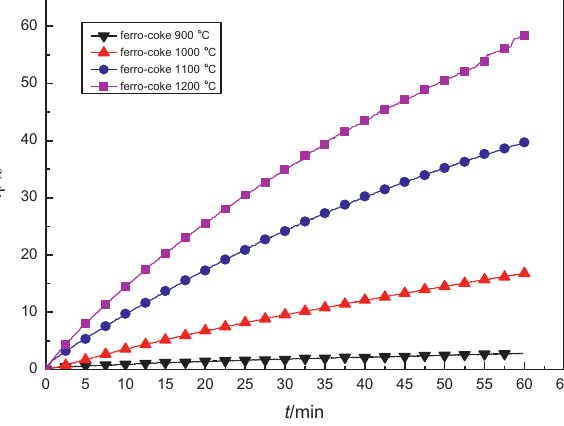
Figure 4: Weight loss of the normal coke at various atmospheres.